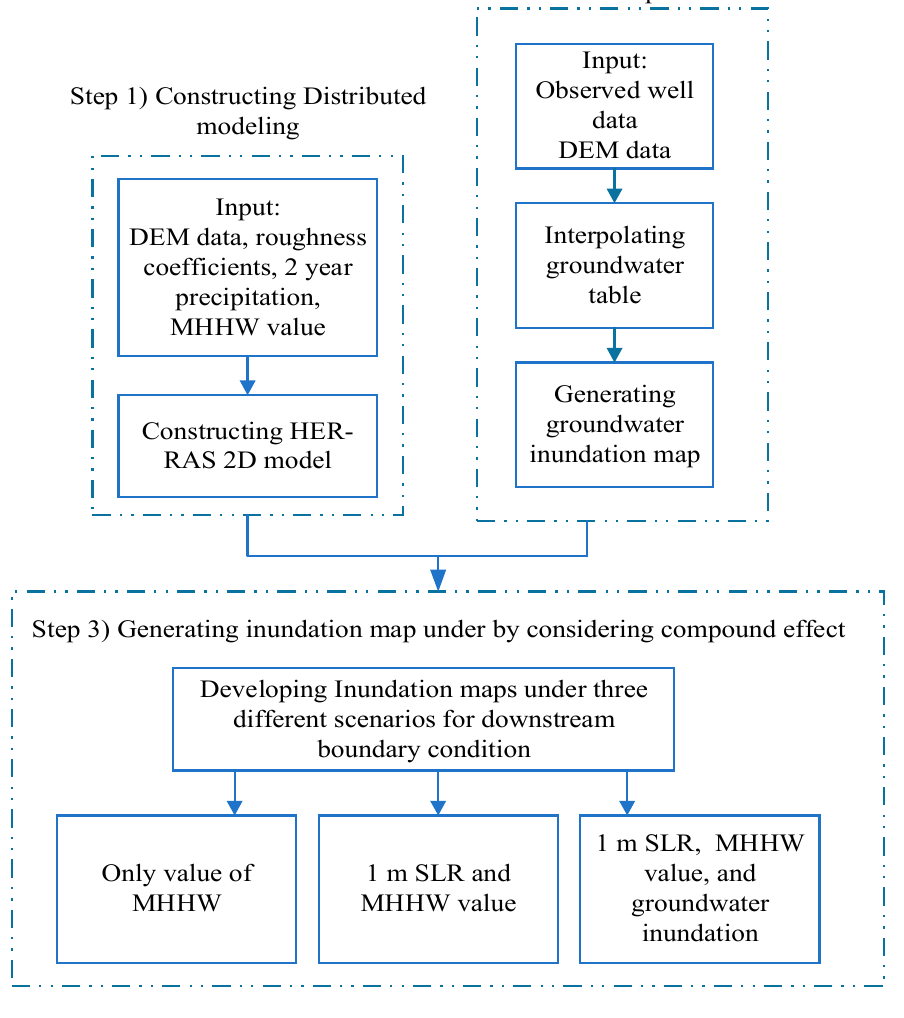
Figure 4. The flowchart of the proposed methodology for developing inundation map of studied compound effects.